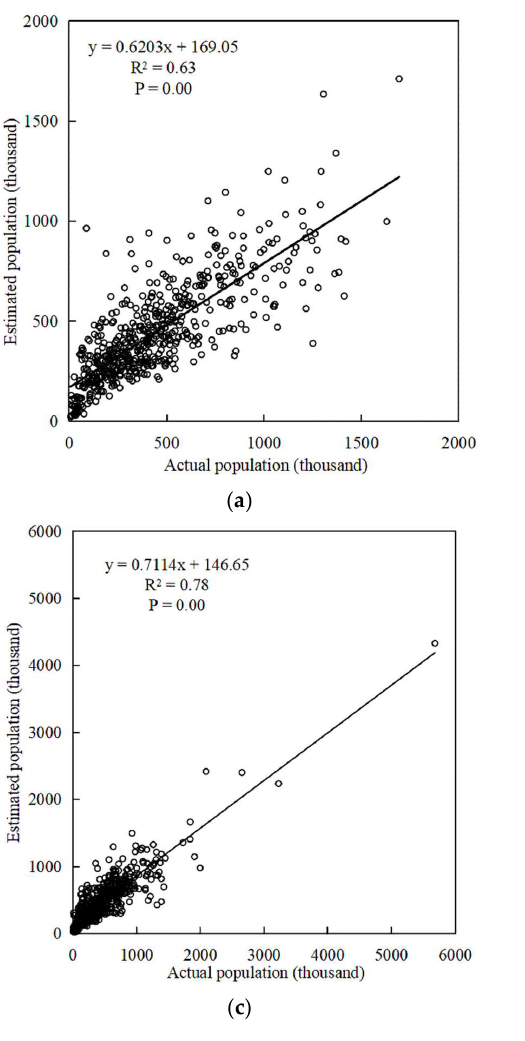
Figure 9. Scatter plots of census data and model simulation results of ( a ) 2000, ( b ) 2010, and ( c ) 2020.